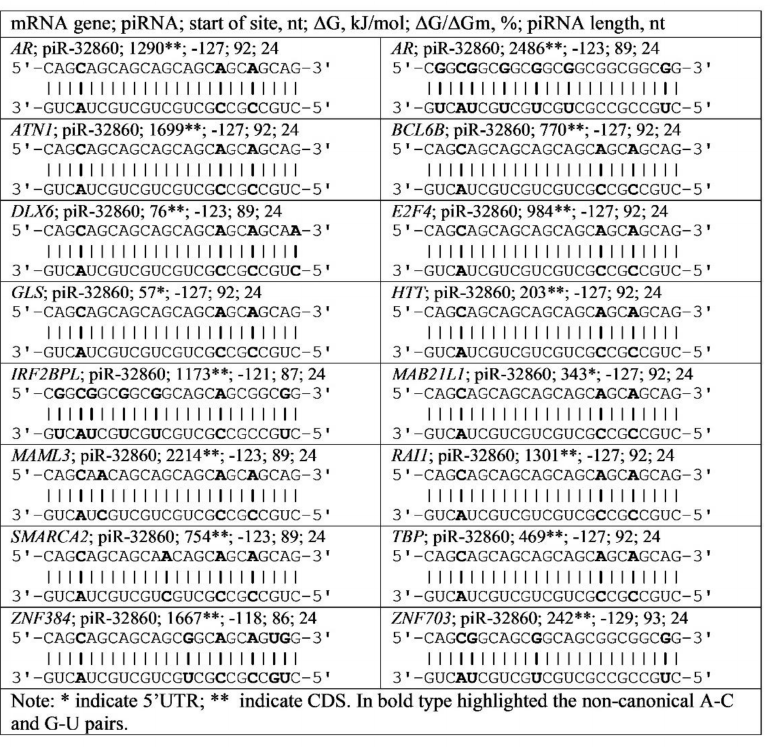
Figure 5. Schemes of piR-32860 interaction with mRNA regions of various genes containing CAG and CGG